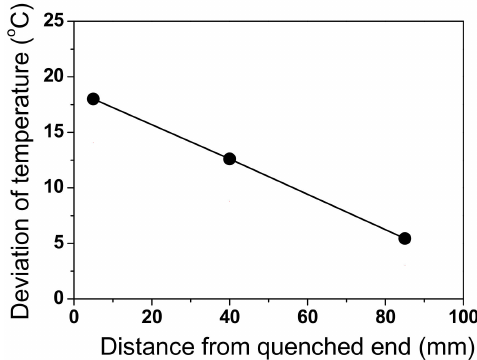
Figure 9. The standard deviation of temperature between the center and surface area of the standard Jominy specimen with cooling time and region.